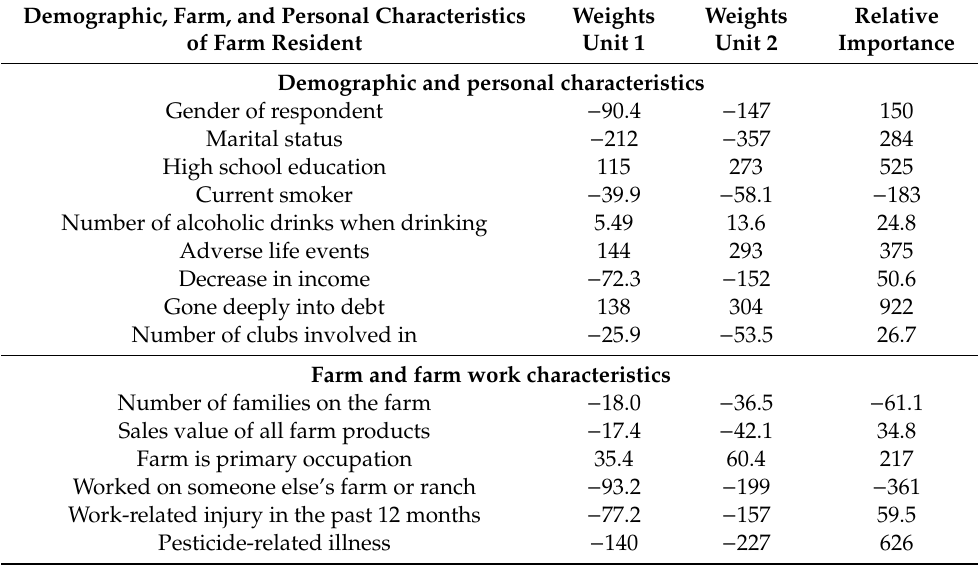
Table 2. Weights and relative importance of 23 predictors from a trained and pruned neural network model with a single hidden layer and two hidden units in 1131 farm residents in Colorado, 1992–1997. Demographic, Farm, and Personal